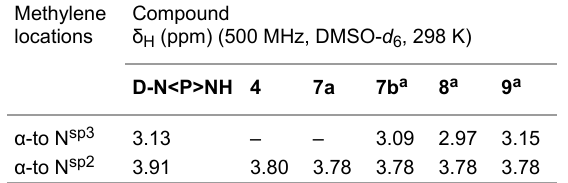
Table 4: 1 H NMR discrimination of methylene protons in piperazine P-1 linkers of compounds D-N<P>NH , 4 , 7a , 7b , 8 and 9 . Methylene